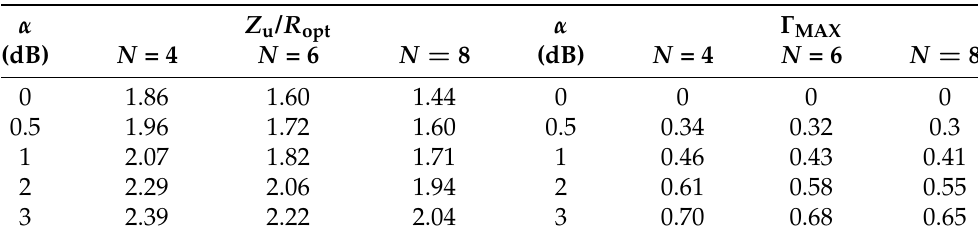
Table 2. Efficiency contours equivalent mismatch settings, for a few cases of knee parameter N and contour level α